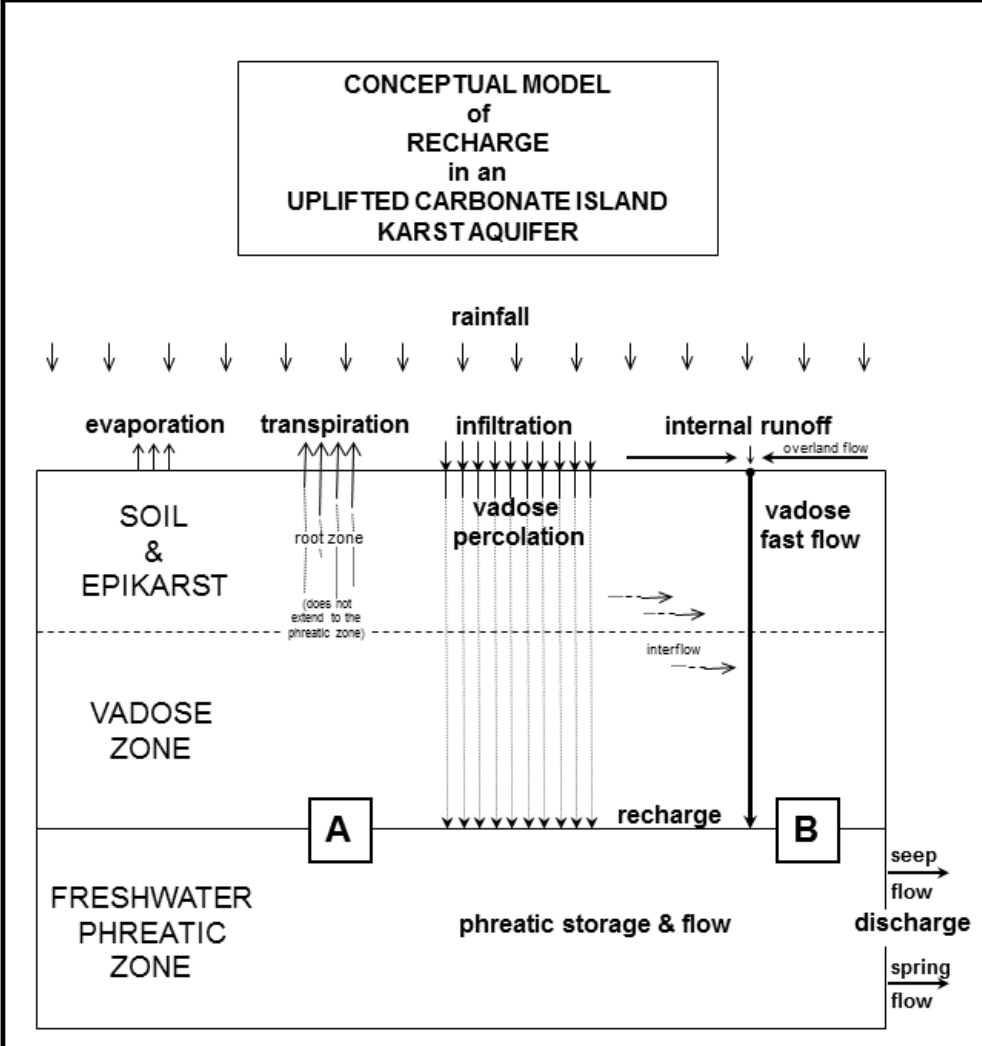
Figure 4. Schematic diagram of autogenic recharge on a carbonate island, modified from Jocson et al. [18]. Recharge at Point A in the water table descends by percolation through the eogenetic matrix of the carbonate rock; it can take six months to reach the top of the freshwater lens. Point B is adjacent to a vadose fast-flow route (pit cave); vadose water can reach the top of the lens within minutes of a meteoric event. Monitoring wells at Points A and B will record dramatically different time responses of the freshwater lens to a given meteoric event.